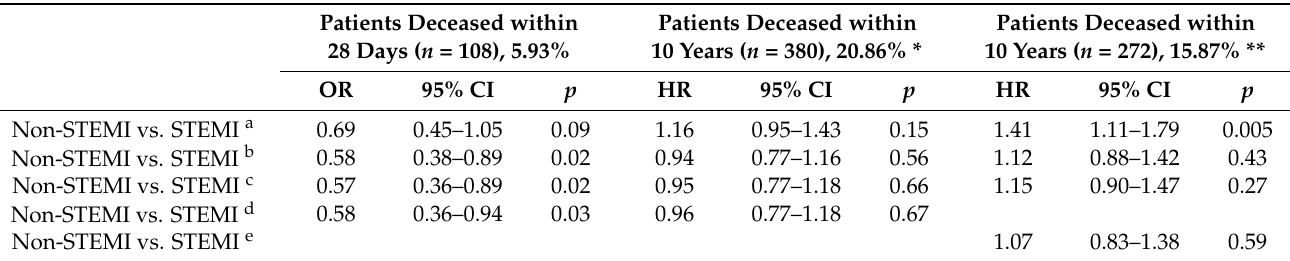
Table 4. Unadjusted and adjusted comparison of survival according to the type of acute coronary syndrome and follow- up